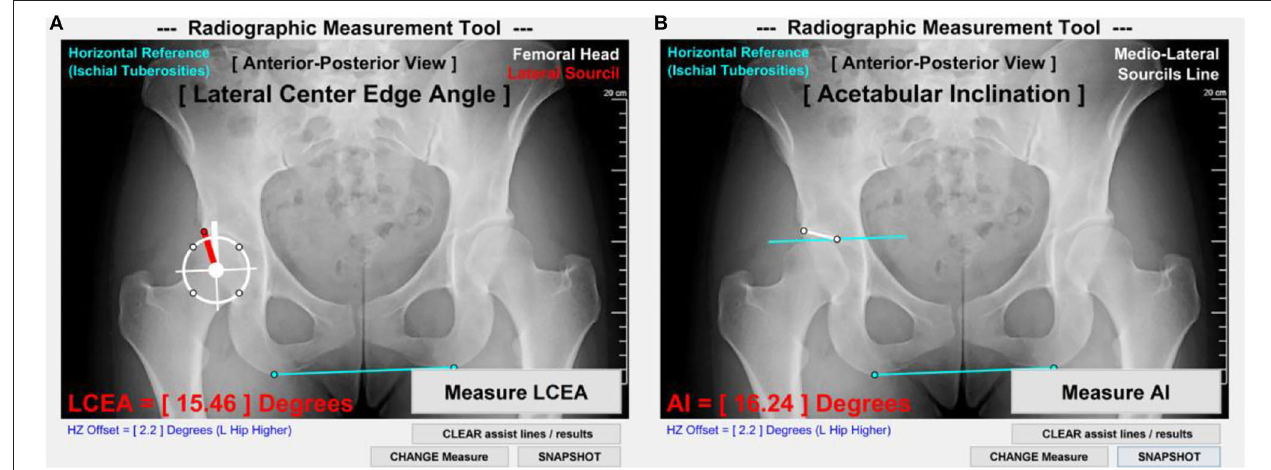
FIGURE 1 | LCEA and AI measurement methods. (A) LCEA was measured as the angle between a first line (thick white) through the femoral head center and perpendicular to the inferior aspect of ischial tuberosities (light blue) and a second line connecting the femoral head center to the lateral aspect of acetabular sourcil (red). (B) AI was measured as the angle between a first line parallel to the inferior aspect of ischial tuberosities and a second line connecting the medial and lateral aspects of acetabular sourcils (thin